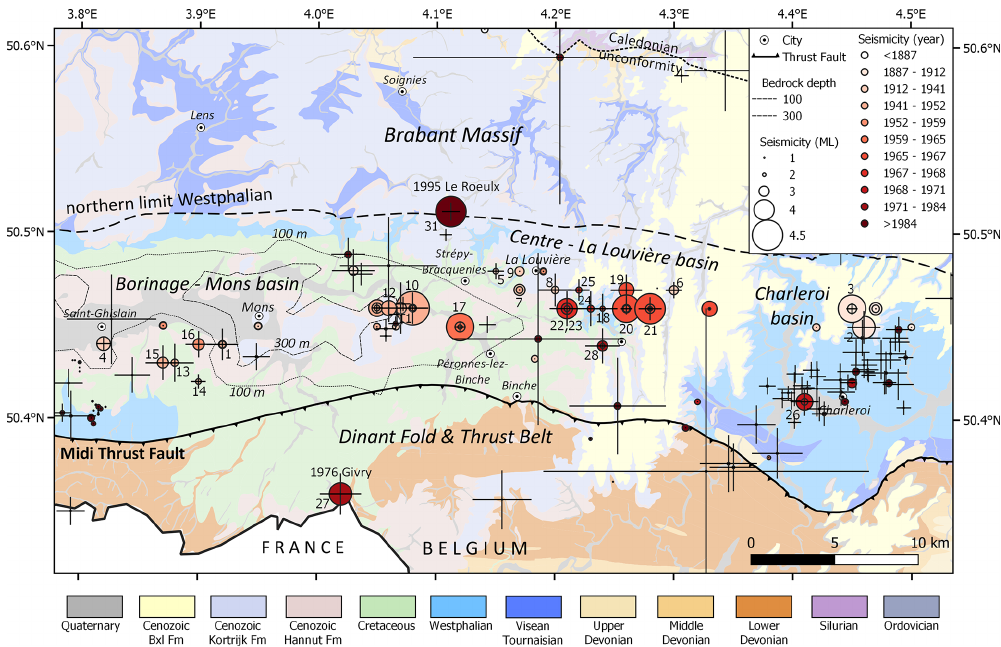
Figure 2. Geological setting of the 1887–2020 seismicity in the Hainaut province with local geological map as background. The Borinage- Mons, Centre-La Louvière and Charleroi basins are the main coal regions in the Hainaut province. Seismicity (up to 2020) coloured as a function of time and sized to magnitude. Black error bars show location uncertainty. Numbers next to the largest earthquakes refer to events in Table 1 and to macroseismic maps in the Atlas in the Supplement. Geology in the background based upon http://www.onegeology.org/. Reproduced with the permission of © OneGeology. All rights